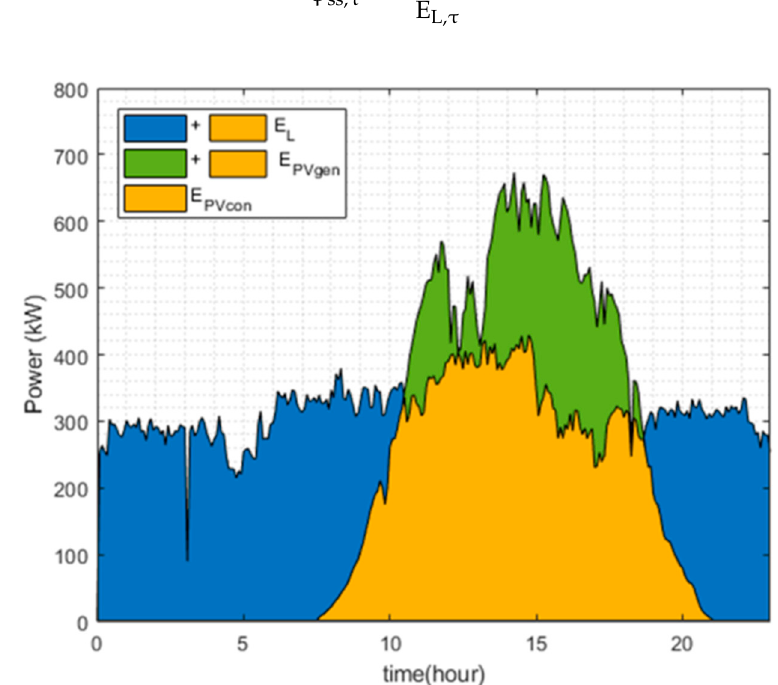
Figure 5. Daily load and photovoltaic generation profiles. Load consumption (blue + orange areas), E L , photovoltaic generation (orange + green areas), E PV,gen , and photovoltaic self-consumed energy (orange area), E PV,con .